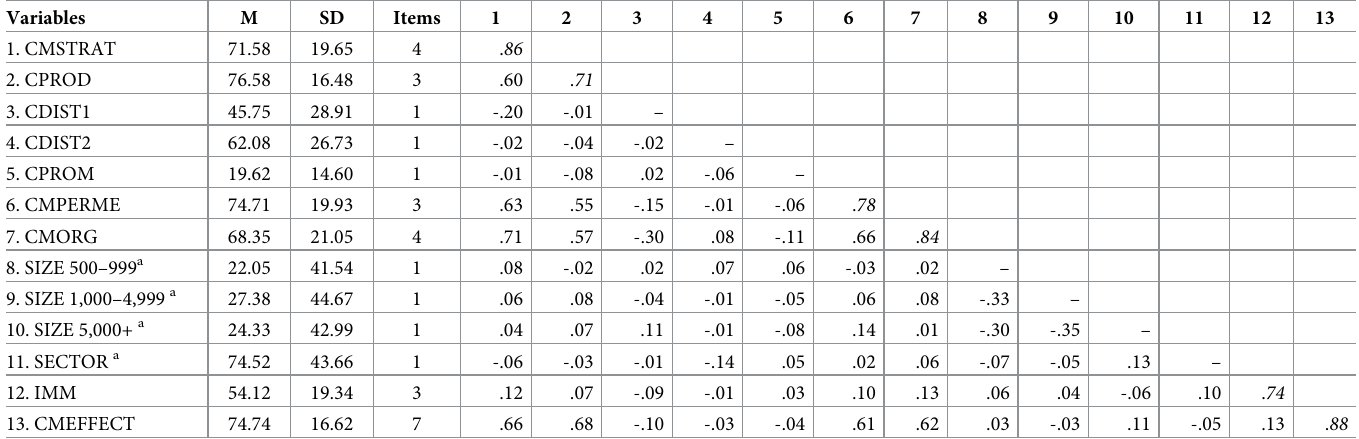
Table 1. Means, standard deviations, correlations and Cronbach’s alphas of study variables.